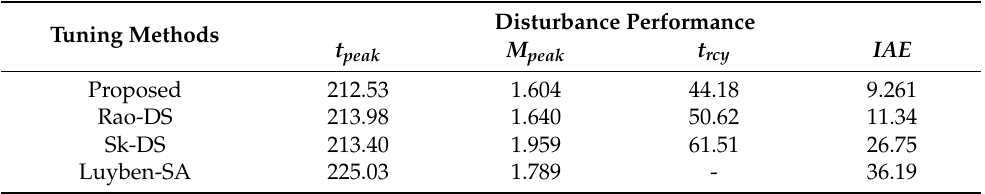
Table 6. Quantitative comparison of the responses to disturbance in PIPTD under Gaussian noise N(0, 0.05 2